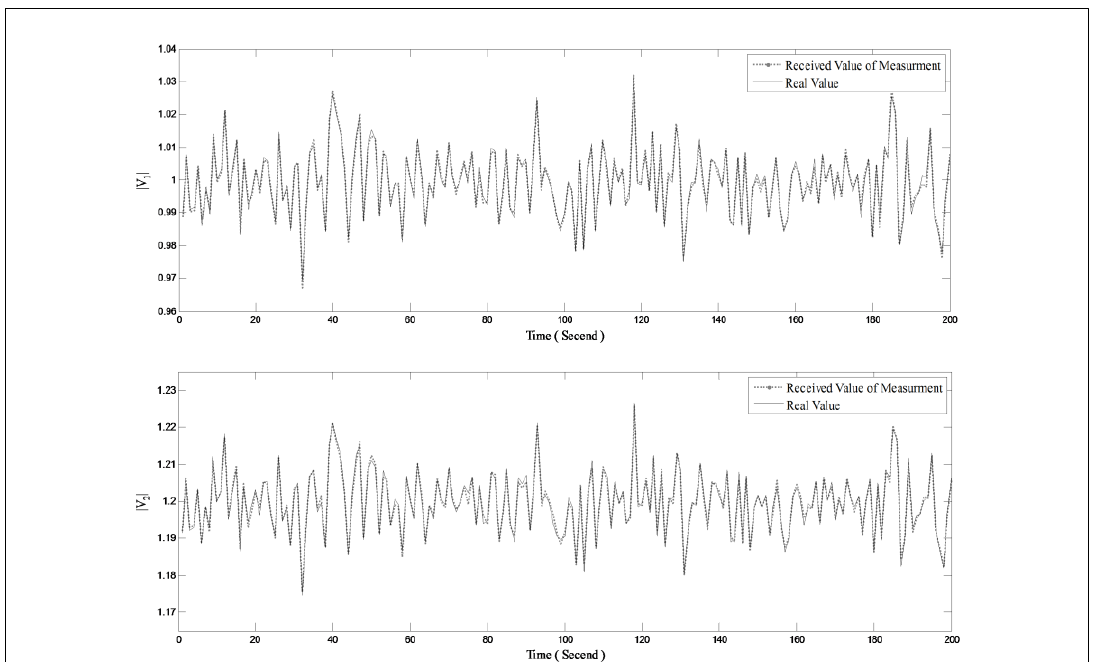
Figure 3. Received values of two